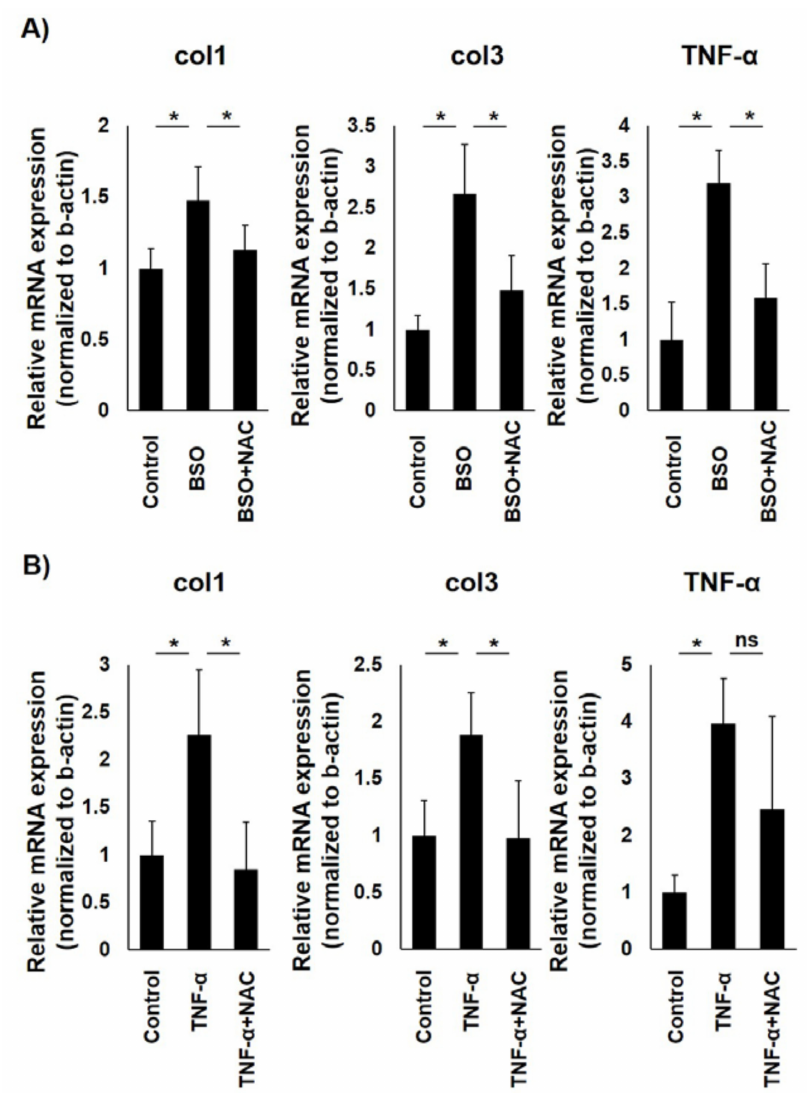
Figure 3. Real-time RT-PCR analysis to assess oxidative stress impact on ligamentum flavum (LF) cells. ( A ) Buthionine sulfoximine (BSO)-mediated induction of type I and type III collagen and TNF-